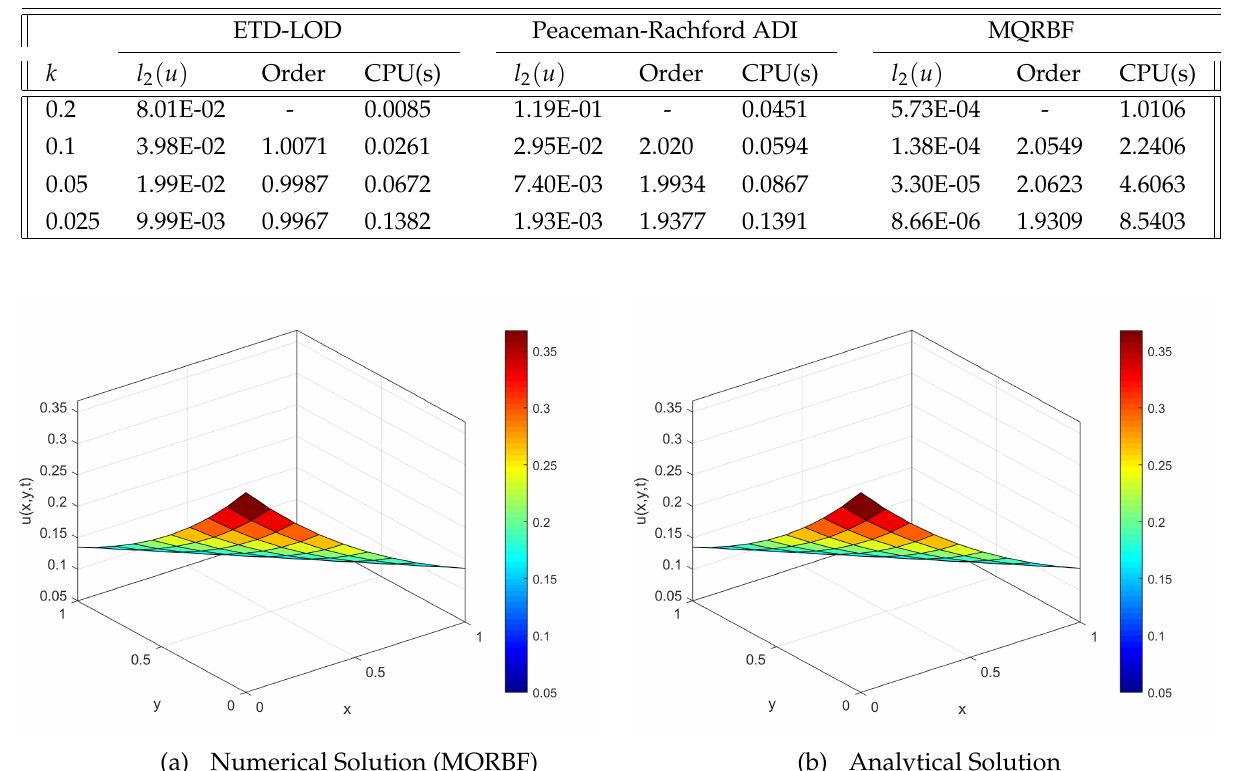
Table 2. Comparison of the schemes ETD-LOD, Peaceman-Rachford ADI and MQRBF for Test Problem 2 in terms of l 2 − norm error, rates of convergence, and computational efficiency at t = 2.0 (only for dimensionless concentration u ).